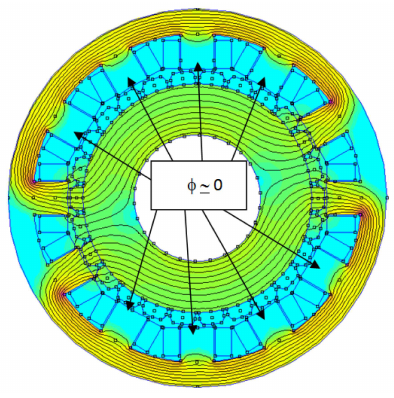
Figure 12. Structures of the active part of a 26 pole 12 slot generator that uses FSCW. With four coils powered and no MMF in magnet, the flux uses a large area of the stator back iron as main path to close the magnetic loop.